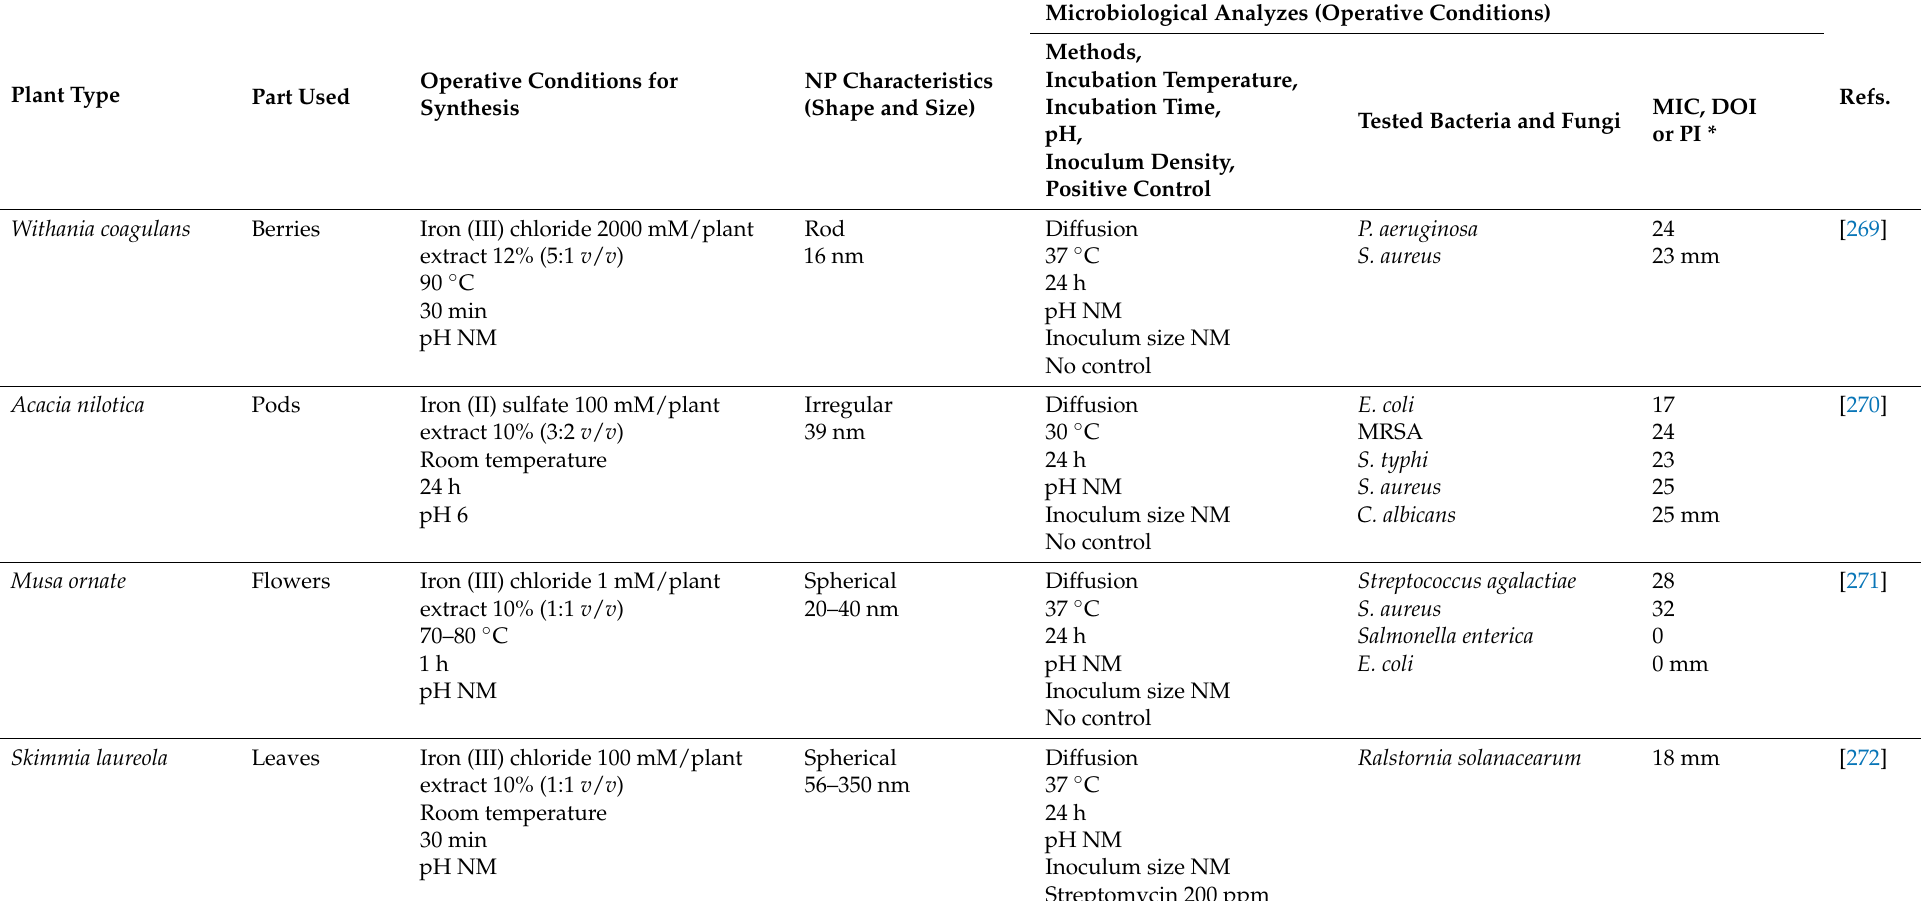
Table 8. Antimicrobial green-synthesized iron